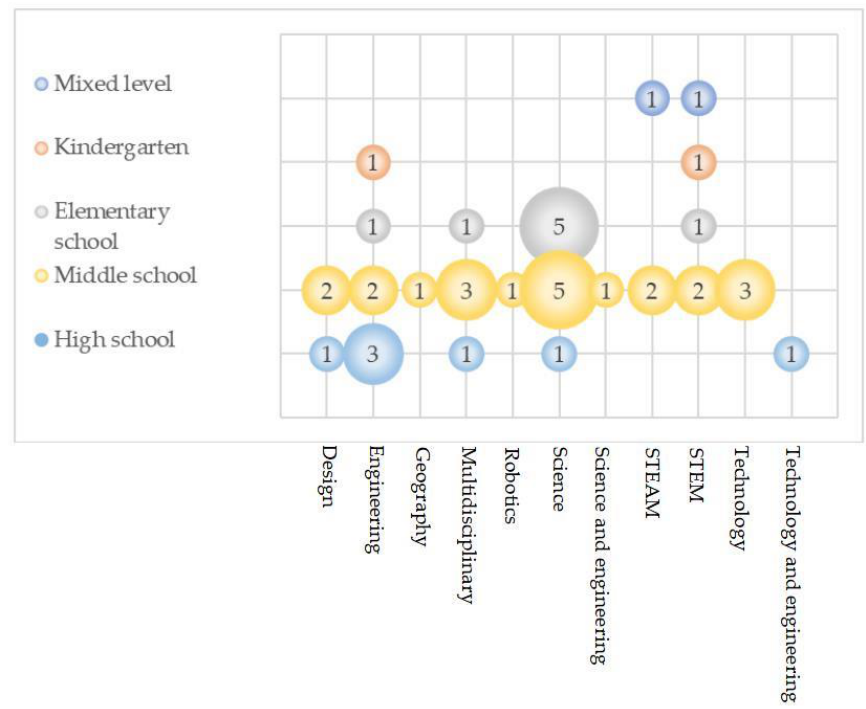
Figure 6. The number of empirical papers by educational level and curriculum.